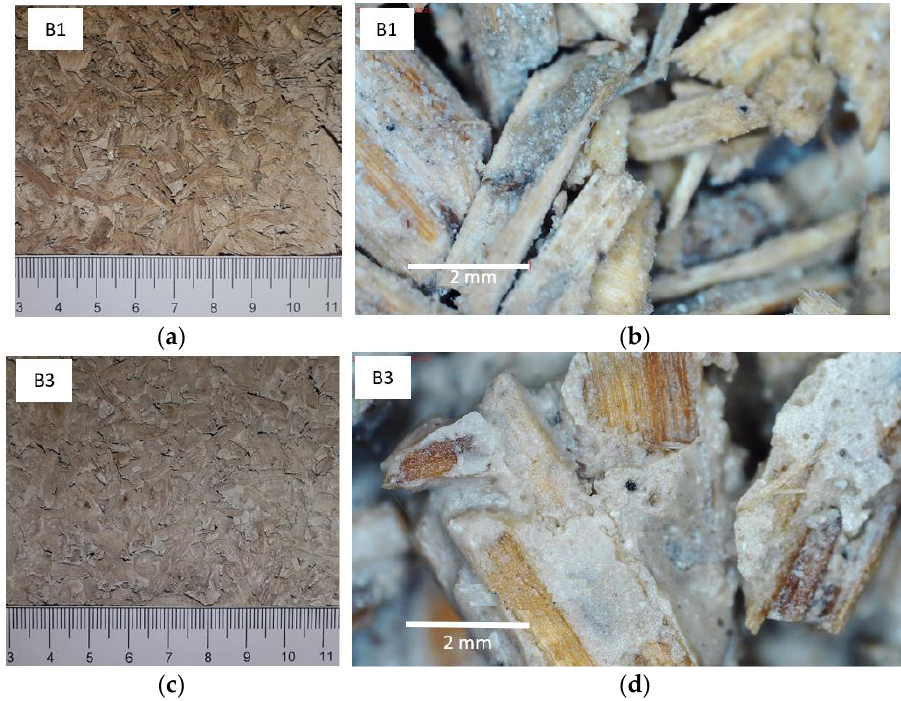
Figure 2. Macro and micro structure of BAC: ( a ) macro and ( b ) micro structure of BAC with low gypsum content (B1); ( c ) macro and ( d ) micro structure of BAC with high gypsum content (B3). Table 3. Physical and mechanical properties of gypsum BAC.